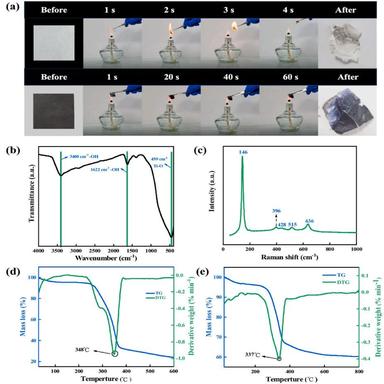
(a) Burning test chart for original paper and AMA composites. (b, c) Infrared spectroscopy and Raman spectrum of residue after composites burning. (d, e) TG and DTG diagram of original paper and AMA composites.